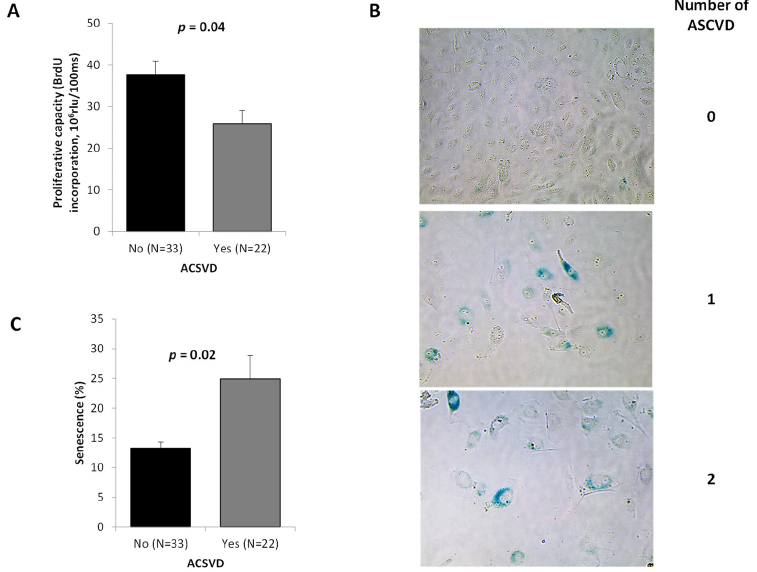
Figure 2. ECFC proliferative capacity and senescence according to ASCVD presence and severity. ECFC were used at passage 3 as described in Materials and Methods. ( A ) Proliferation assayed by BrdU incorporation. Results were expressed in rlu/s of luminescence measurements. Data represent mean ± SD of 55 independent experiments performed in triplicate. ( B ) Representative images from ECFC according to the extent of ASCVD (magnification 20X). ( C ) The percentage of senescent cells was determined as the number of cells expressing SA- β -galactosidase (blue cells) relative to the total number of cells in each field. Histograms represent mean ± SD of 55 independent experiments performed in triplicate. ASCVD indicates atherosclerotic cardiovascular disease. p of comparisons are obtained from the Mann–Whitney test.